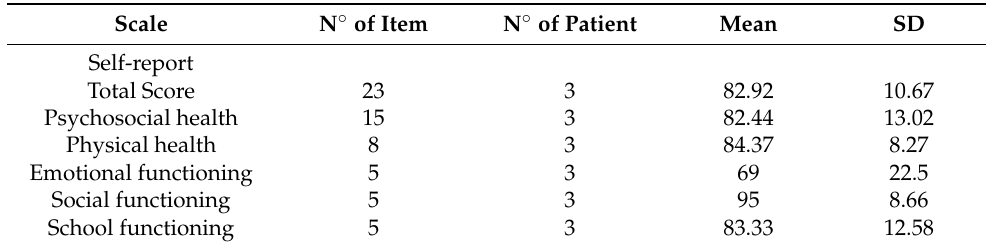
Table 3. Item score distributions for the Pediatric Quality of Life Inventory (PedsQL) 4.0 Generic Core Scales.